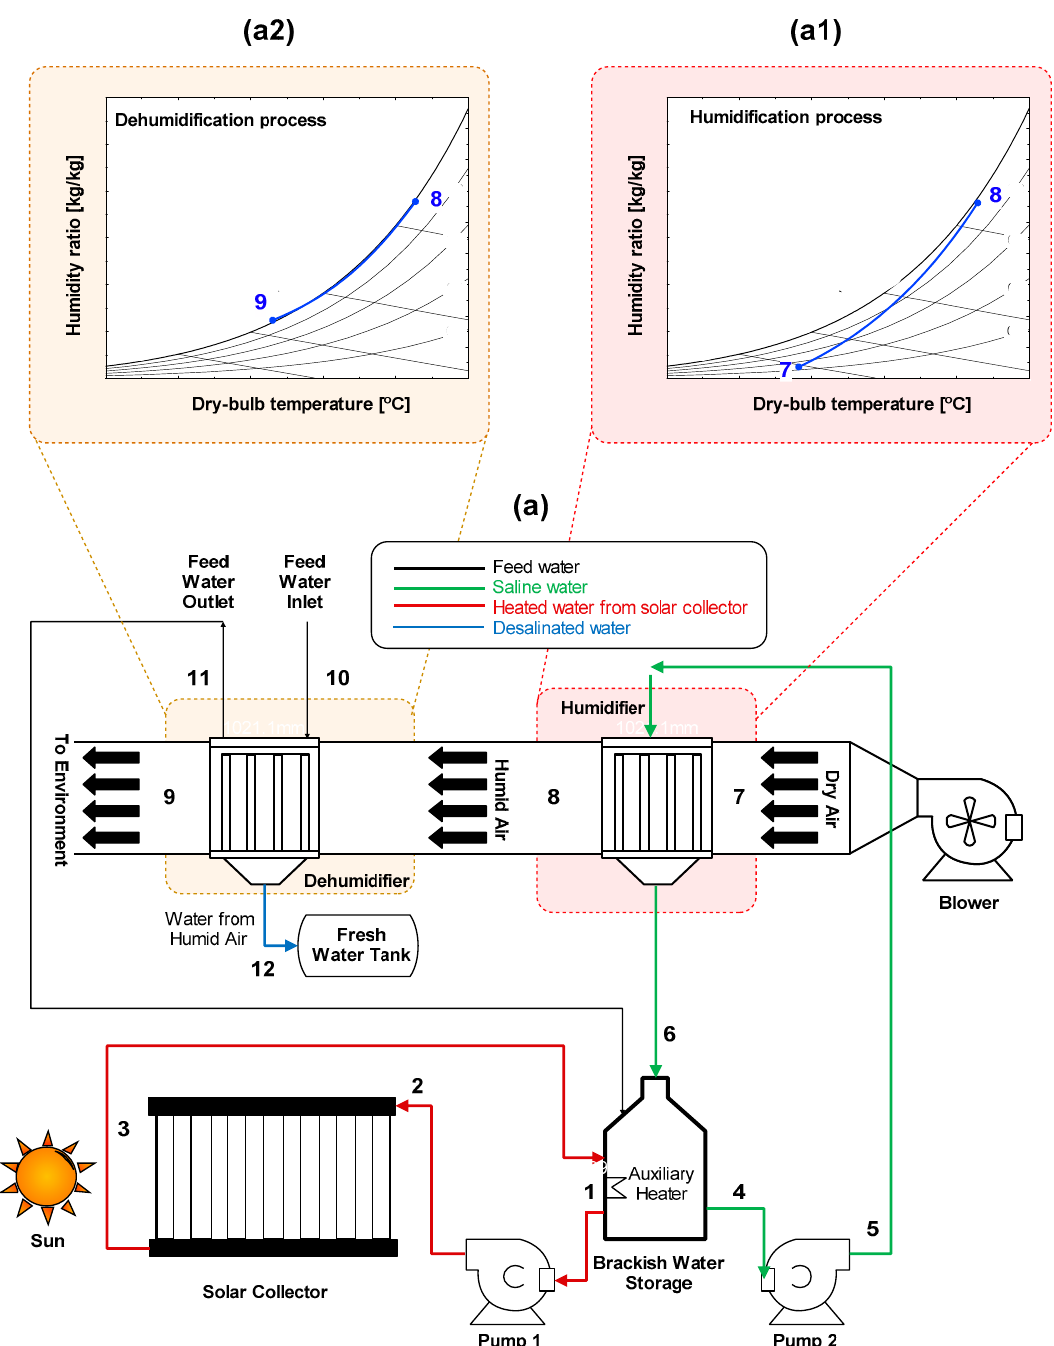
Figure 2. Desalination system scheme with waste heat recovery process (the description of the state numbers 1–12 is discussed in Section 2).